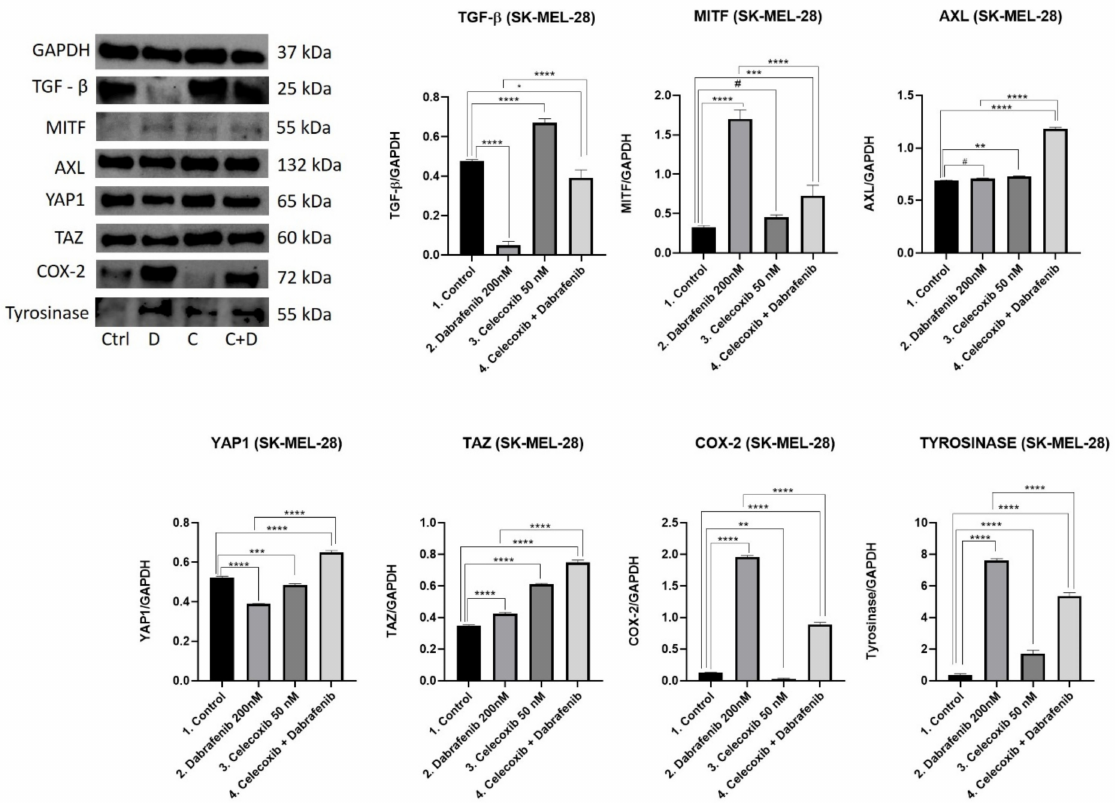
Figure 7. Western blot analysis for SK-MEL-28. Results were statistically analyzed using GraphPad Software, Ordinary One-way ANOVA test, Multiple comparisons. Each bar represents mean ± standard deviation, n = 3. # = p > 0.05 (not significant), * = p < 0.05, ** = p < 0.01, *** = p < 0.001, **** = p <